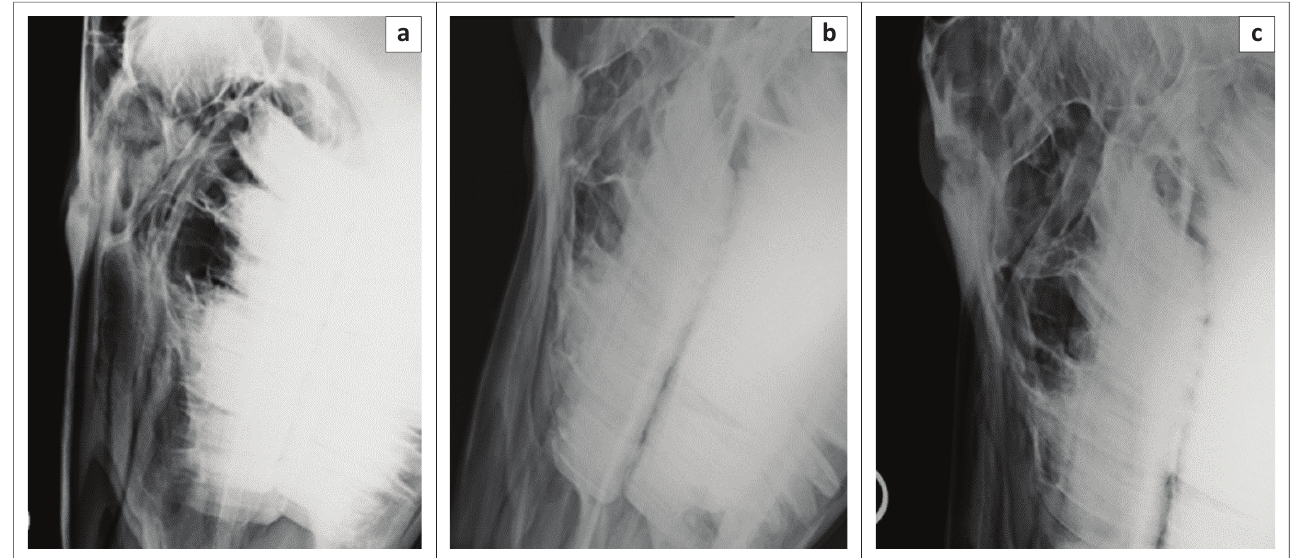
FIGURE 4: (a) Latero-lateral, (b) LeDRtVO and (c) RtDLeVO radiographic projections of the affected area, demonstrating the smooth solid periosteal reaction associated with an irregular radiolucent fissure line and a poorly marginated oval radiolucency associated with this feature particularly obvious in (c). Also note the depressed appearance of the caudal nasal and rostral frontal bones, especially prominent in